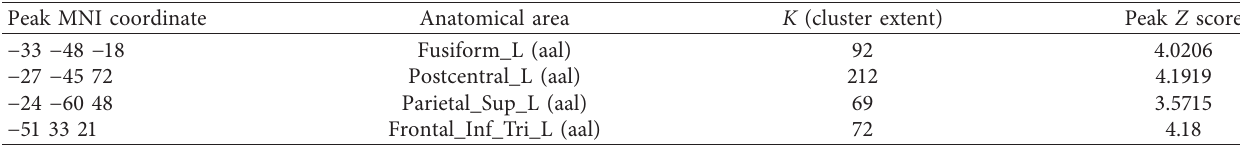
Table 3: Regions of P300 FMRI activation to novels-targets